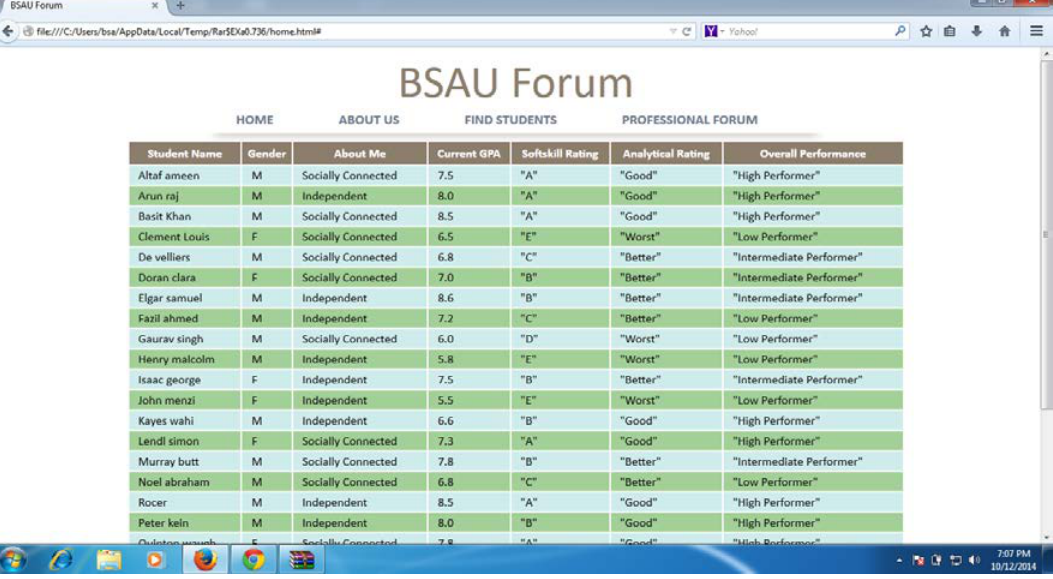
Figure 3. BSAU forum back-end data